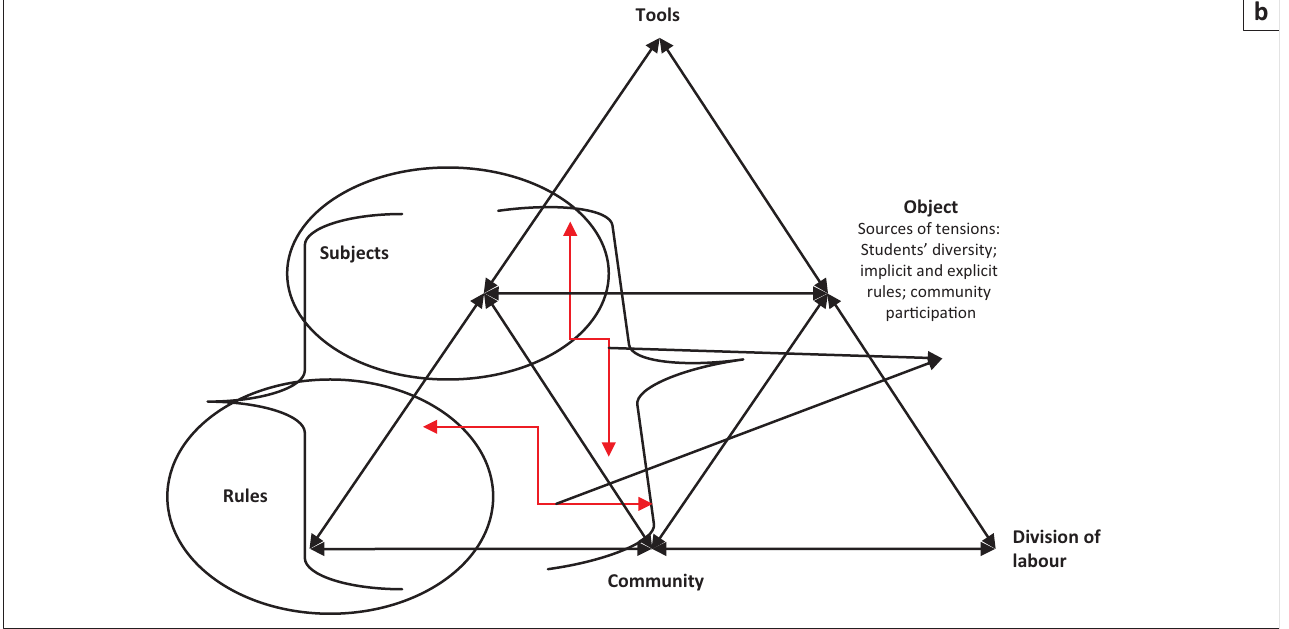
FIGURE 5 (Continues...): (a) The main activity system; (b) Section of activity system where transition causes